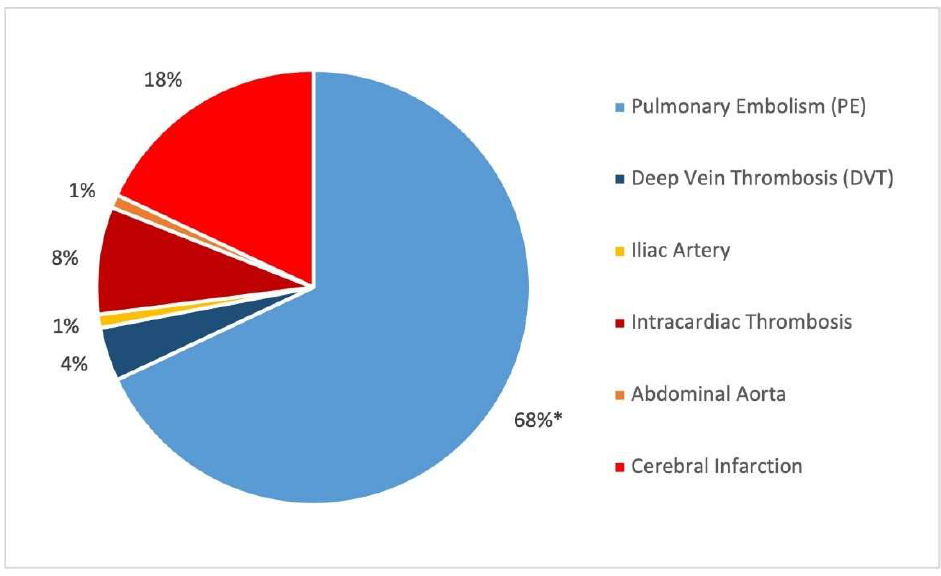
Figure 3. Location of the thrombotic events ( n = 100). The venous ones ( n = 72) are represented in blue, and the arterial ones ( n = 28) are represented in orange-red; * means that the 68 cases with PE include 5 cases with DVT as well.